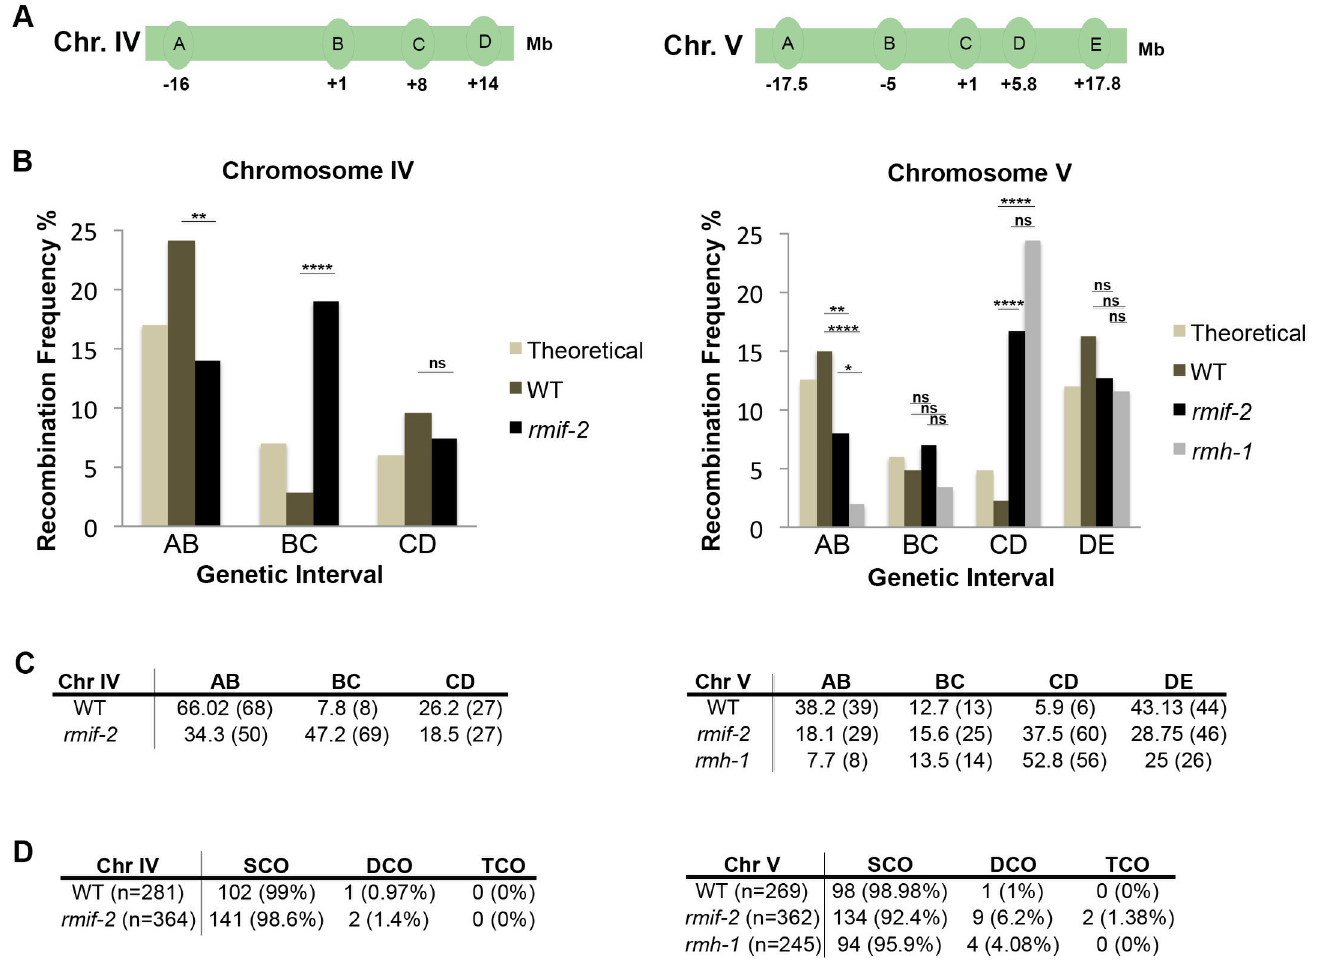
Fig 7. RMIF-2 controls the CO position and suppresses the formation of additional COs. (A) Schematic diagrams of chromosome (Chr.) IV (left) and V (right), showing the locations of the SNPs used in the PCR-based recombination assay. (B) Recombination frequencies on chromosomes IV (left) and V (right) assessed for different genetic intervals in WT, rmif-2 and rmh-1 . The ‘theoretical’ column is the expected recombination frequency based on the published genetic distance (http://www.wormbase.org). Statistical significance for recombination frequency over the total amount of worms was calculated using the Fisher’s exact test: Chr. IV WT vs rmif-2 ns (p = 0.568); Chr. V WT vs rmif-2 ns (p = 0.4579); wt vs rmh-1 ns (p = 0.6507); rmif-2 vs rmh-1 ns (p = 0.8662). Statistical significance of recombination frequencies between specific SNPs was calculated via a χ 2 test: Chr IV Interval AB: WT vs Theoretical ns (p > 0.05); WT vs rmif-2 �� (p = 0.0048); Interval BC: WT vs Theoretical ns (p > 0.05); WT vs rmif-2 ���� (p < 0.0001); Interval CD: WT vs Theoretical ns (p > 0.05); WT vs rmif-2 ns (p = 0.2749). Chr V Interval AB: WT vs Theoretical ns (p > 0.05); WT vs rmif-2 �� (p = 0.0062); WT vs rmh-1 ���� (p < 0.0001); rmif-2 vs rmh-1 � (p = 0.0362). Interval BC: WT vs Theoretical ns (p > 0.05); WT vs rmif-2 ns (p = 0.5759); WT vs rmh-1 ns (p = 0.8938); rmif-2 vs mrh-1 ns (p = 0.6760). Interval CD WT vs Theoretical ns (p > 0.05); WT vs rmif-2 ���� (p < 0.0001); WT vs rmh-1 ���� (p < 0.0001); rmif-2 vs rmh-1 ns (p = 0.1063). Interval DE: WT vs Theoretical ns (p > 0.05); WT vs rmif-2 ns (p = 0.0981); WT vs rmh-1 ns (p = 0.0533); rmif-2 vs rmh-1 ns (p = 0.6122). Number of animals analyzed Chr IV: WT 281 worms, rmif-2 364 worms; Chr V: WT 269 worms, rmif-2 362 worms; rmh-1 245 worms. COs were shifted toward the chromosome center in the mutants compared with the WT. (C) The table contains the percentage of SNPs in each genetic interval on Chr IV (left) and Chr V (right). The number of COs per interval is shown in brackets. (D) Table displaying the number and percentage (in brackets) of single (SCO), double (DCO) and triple (TCO) crossovers in the genotypes analysed. n indicates the number of worms analyzed. χ 2 test analysis showed that the change in crossover distribution between WT and rmif-2 is significantly different on both chromosome IV ( ��� p = 0.0006) and chromosome V ( �� p = 0.0027). The change in crossover distribution between WT and rmh-1 on chromosome V was statistically significant ( ���� p < 0.0001). The change in crossover distribution between rmif-2 and rmh-1 on chromosome V was not statistically significant (p =